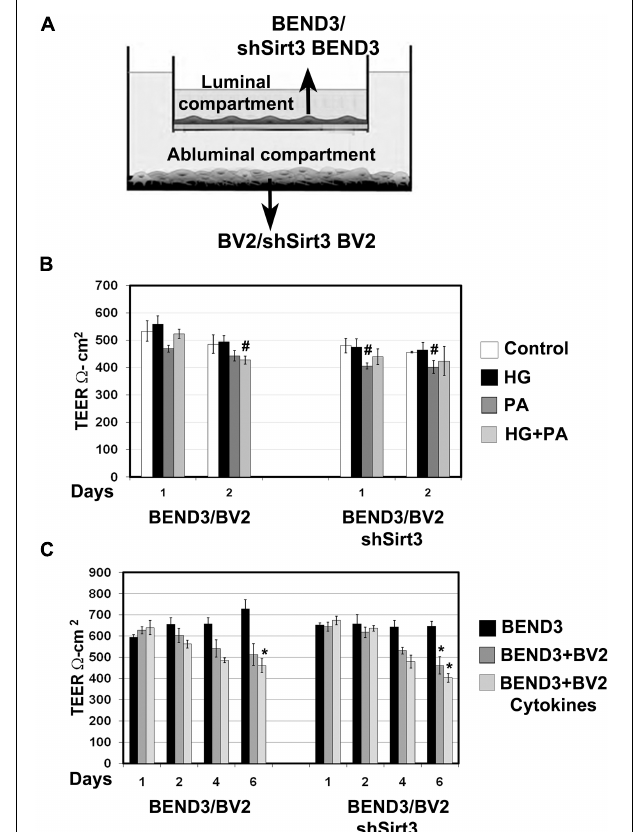
In vitro co-culture model of microglial and endothelial cells: Culture of BEND3 or shSirt3-BEND3 cells in the Boyden chamber inserts, while BV2 or shSirt3-BV2 cells in the bottom wells were performed. (B) The cocultures were incubated in the absence and presence of high glucose (HG 30 mM), palmitic acid (PA 300 µ m), or combination of both for 24 h and 48 h. TEER was measured, using EVOM resistance meter after 24 h and 48 h. (C) The cocultures were exposed to a combination of cytokines (20 ng/ml each of TNF- α , IL-1 β , and IFN- γ ) for 6 days, followed by TEER measurement. # , P < 0.05; *, P < 0.01 vs untreated controls. shSirt3,